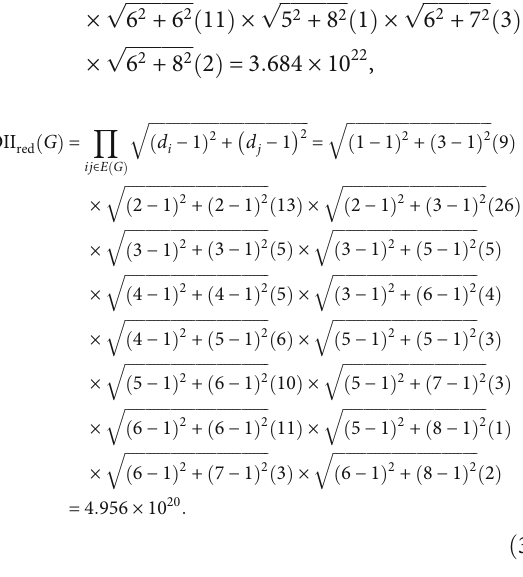
p ffiffiffiffiffiffiffiffiffiffiffiffiffiffi 1 2 + 3 2 p ffiffiffiffiffiffiffiffiffiffiffiffiffiffi 3 2 + 3 2 p ffiffiffiffiffiffiffiffiffiffiffiffiffiffi 3 2 + 6 2 p ffiffiffiffiffiffiffiffiffiffiffiffiffiffi 5 2 + 6 2 p ffiffiffiffiffiffiffiffiffiffiffiffiffiffi 5 2 + 8 2